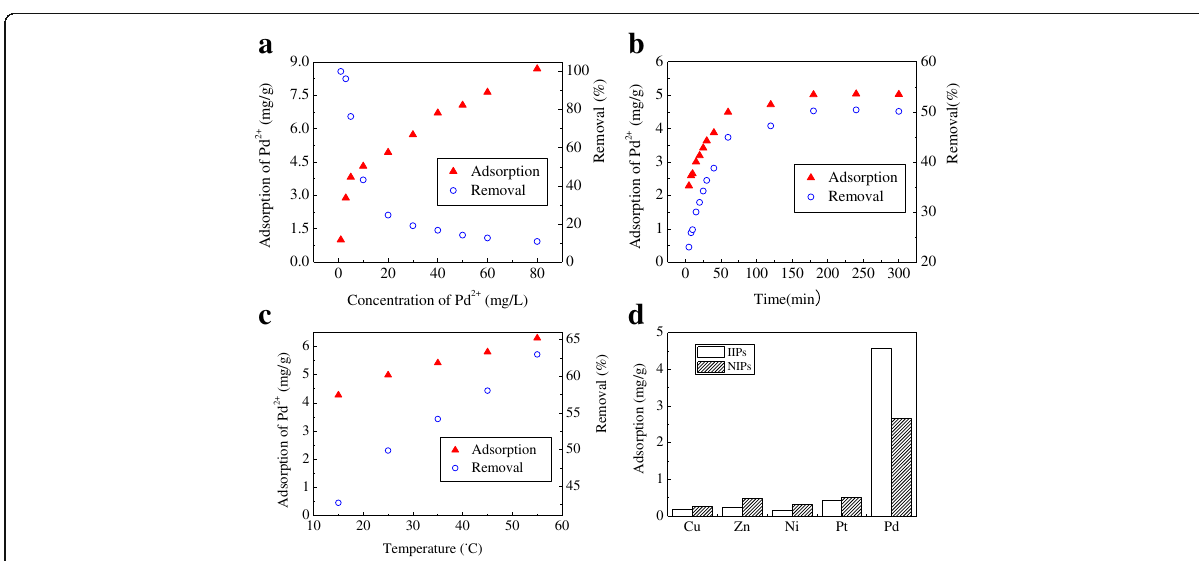
Fig. 5 Effects of ( a ) initial concentration, ( b ) contact time, ( c ) temperature and ( d ) multiple metals on adsorption of Pd(II) on Pd(II)